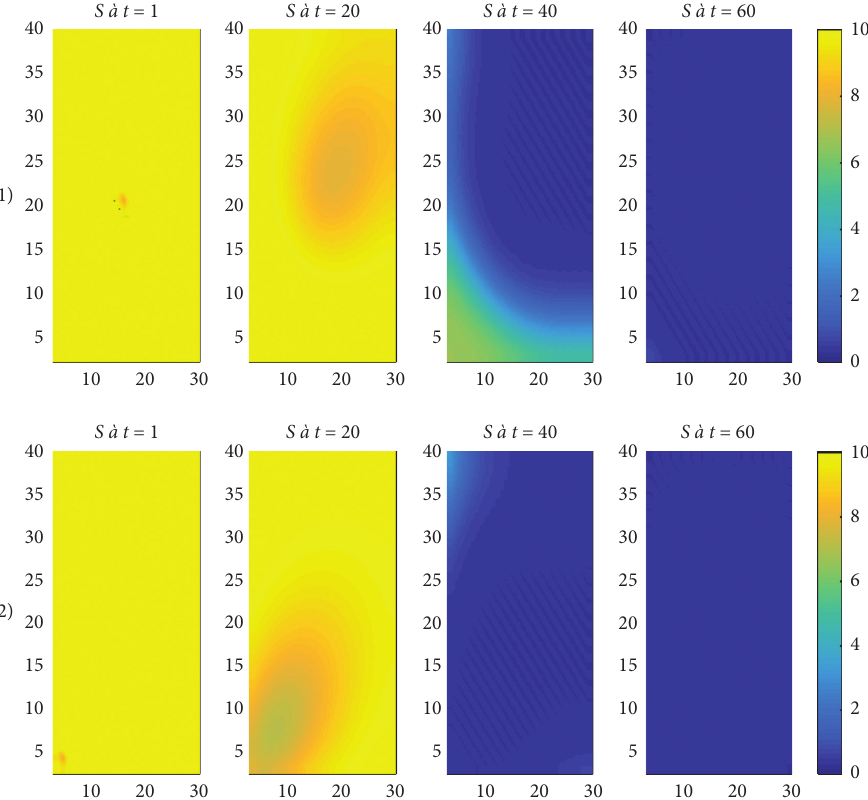
Figure 5: Susceptible behavior within Ω without control (vaccine strategy after 30 days).